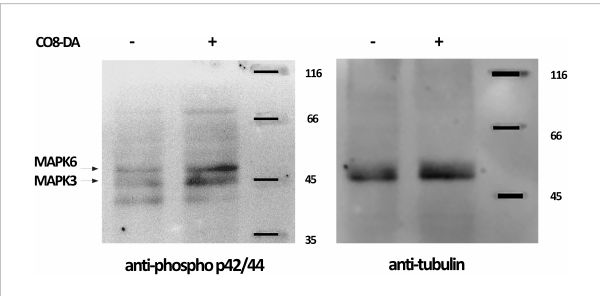
FIGURE 8 CO8-DA-induced MAPK3/6 phosphorylation in Pisum sativum cv. Finale. Plant treatment was done with 10 -5 M CO8-DA (+) as elicitor for 15 min and 0.5x Jensen ’ s medium (-) as a control in glass jars. Western-blots were done to visualize the phospho-MAPK3/6 and tubulin bands using anti – phospho-p44/42 MAPK and anti – a / b - tubulin